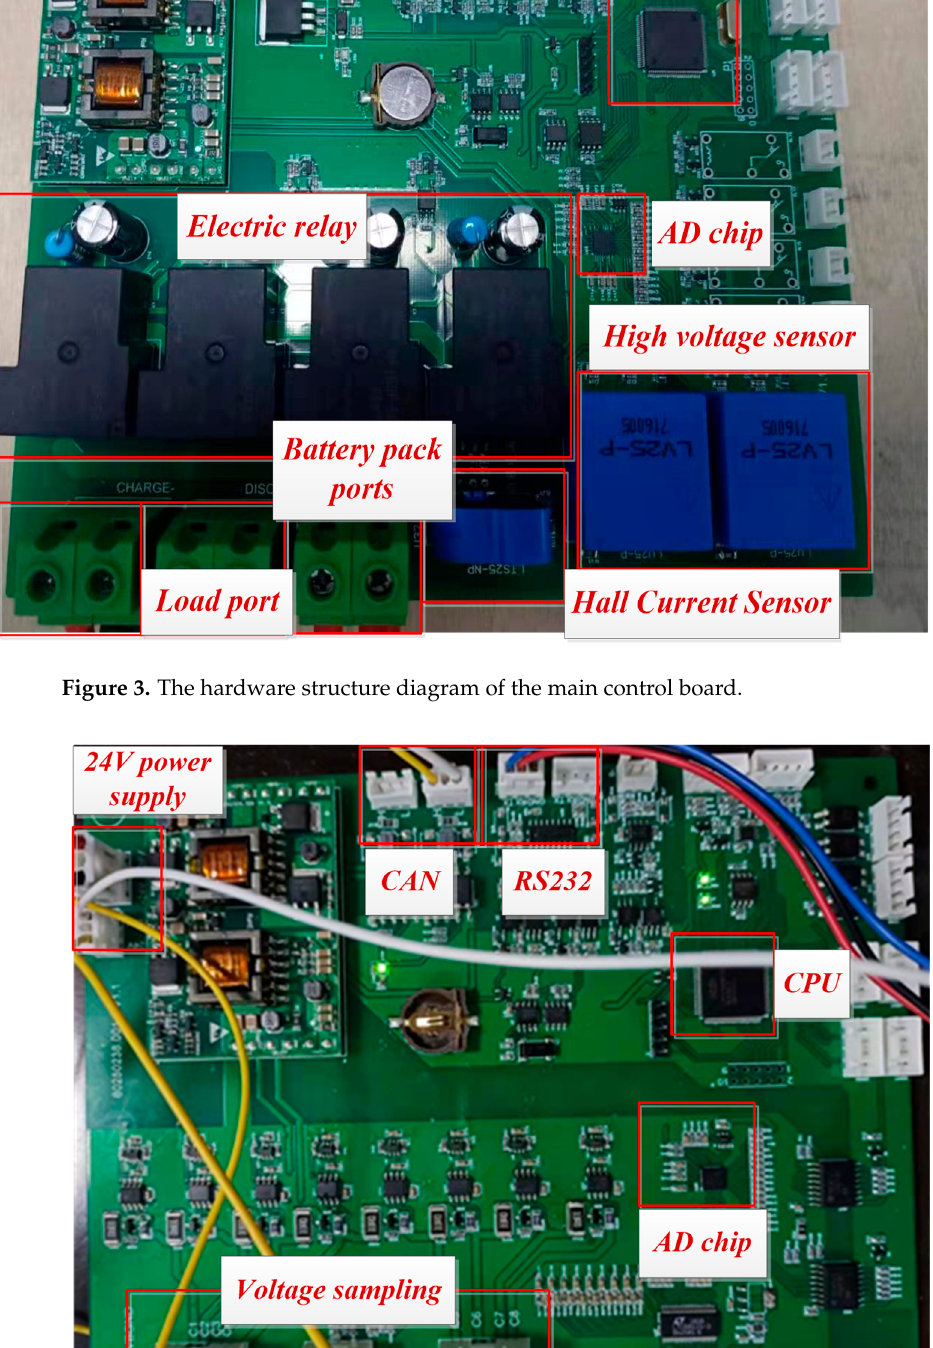
Figure 5. The hardware structure diagram of the temperature control board.